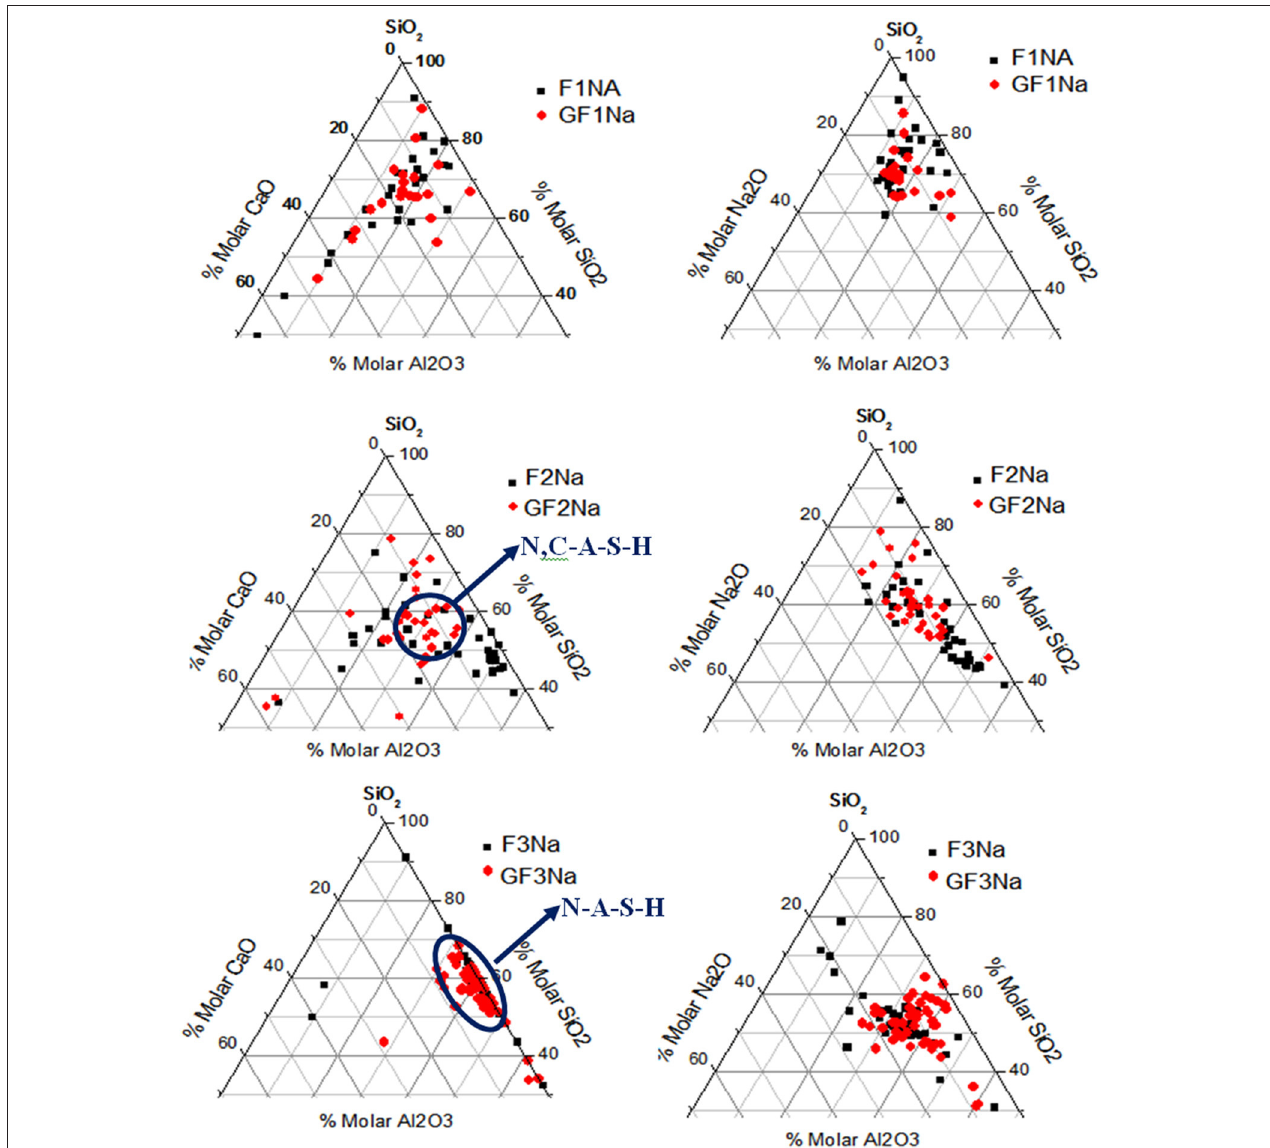
FIGURE 9 | EDX chemical composition of gels formed (qualitative